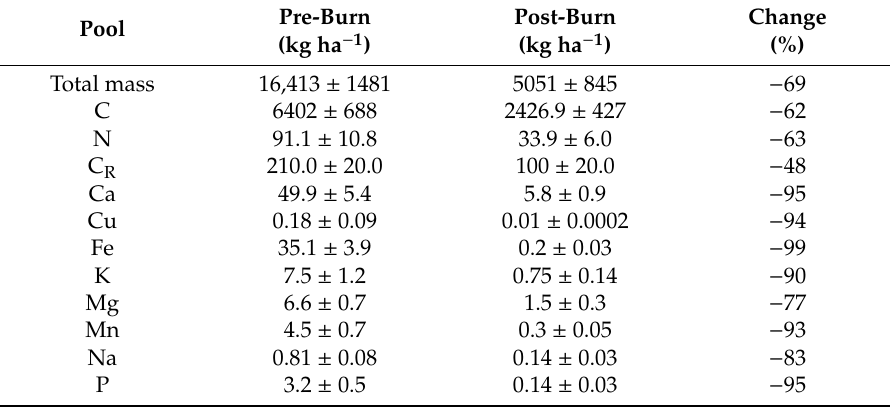
Table 1. Change in forest floor mass, C, N and nutrient pools one-month